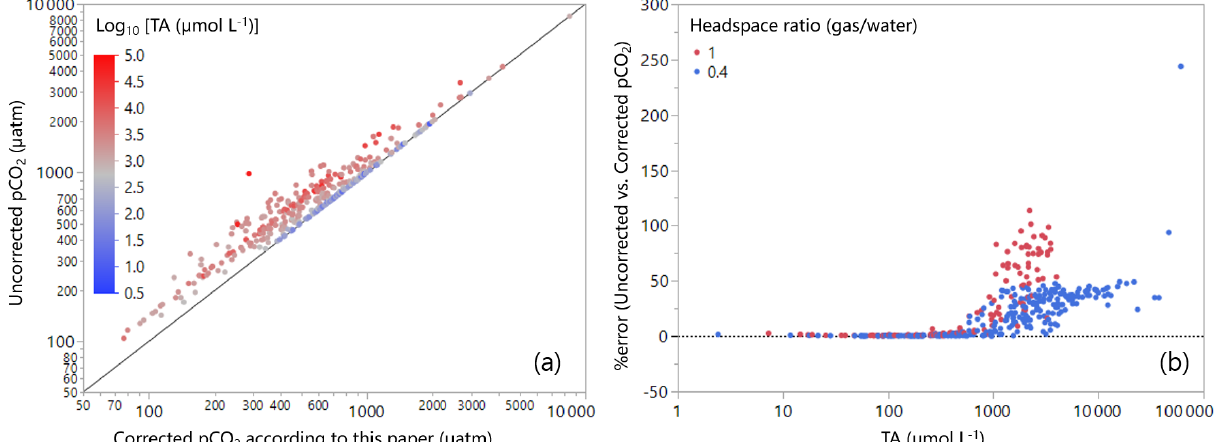
Figure B1. Field data from 377 lakes across Canada (a) for comparing p CO 2 derived from simple headspace calculation with that from the corrected headspace calculation according to this paper (Log 10 [TA (µmolL − 1 )] colour coded). (b) Difference between the uncorrected and corrected p CO 2 expressed as error (%) as a function of TA (µmol L − 1 ) (the headspace ratio colour coded). Note that CO 2 -free gas was used for headspace, and TA values were derived from DIC measurement and pH. More information about the dataset can be found in Huot et al.